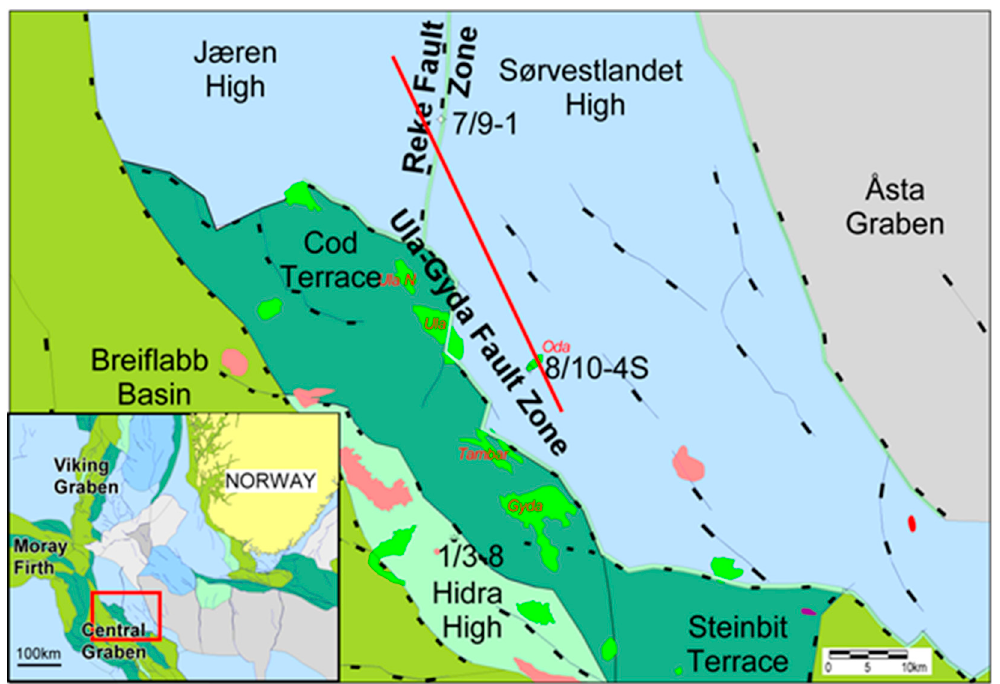
Figure 2. Overview map of the study area situated on the eastern flank of the Central Graben seen as the green basement trend between the blue platform areas. Maps are modified from Norwegian Petroleum Directorate (NPD) maps. The inset map shows the study area situated centrally in the North Sea between mainland UK and Norway. Model 1 is positioned close to Well 1/3-8 on the Hidra High. Model 2 is shown by the red line. Hydrocarbon discoveries are shown in pink and light green.